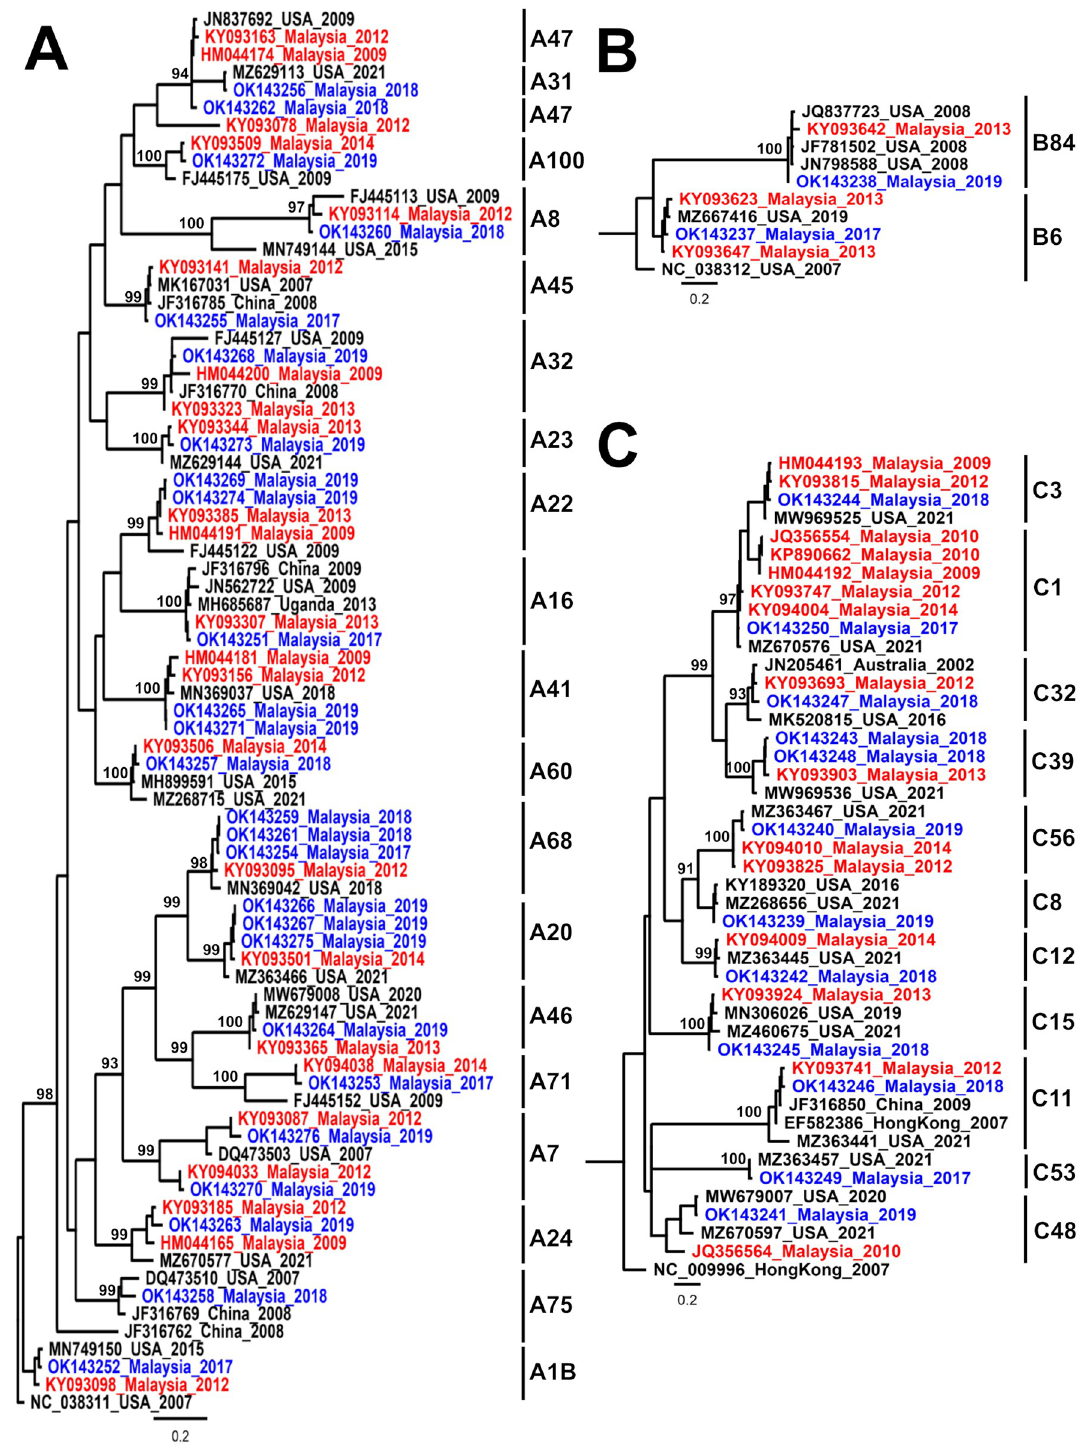
Fig 2. Phylogenetic trees of rhinovirus A, B and C targeting partial VP4/VP2 gene sequences. Strain names are in the format: accession number_country of isolation_year of isolation. The numbers refer to percentage of bootstrap support at key nodes. Malaysian sequences are coloured red and sequences from this study are coloured blue. The phylogenetic trees of rhinovirus A, B and C are rooted with reference genomes with accession numbers NC_038311, NC_038312 and NC_009996, respectively.